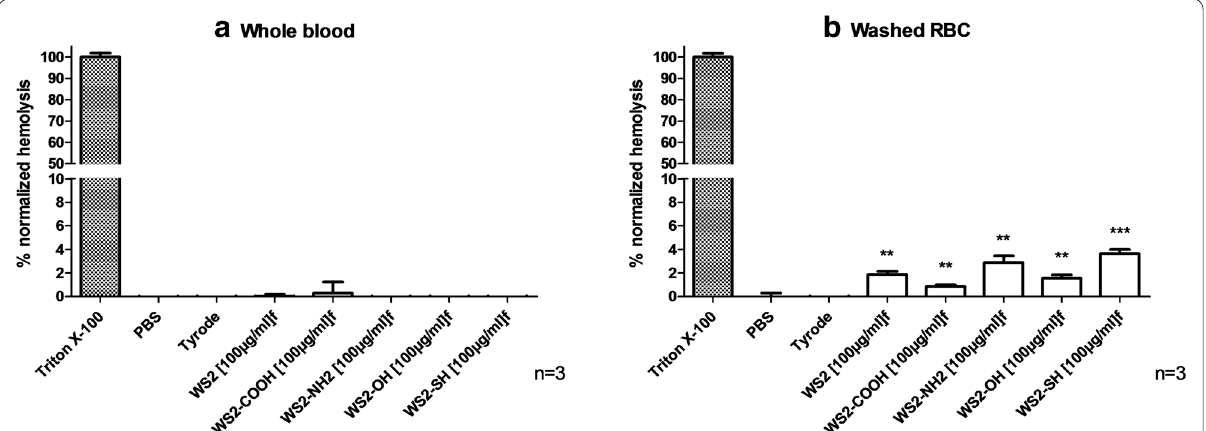
Fig. 2 Impact of INTs‑WS 2 / f ‑INTs‑WS 2 on hemolysis after 1 h at 100 μg/mL. Experiments were performed on a whole blood and b washed RBC. Triton X‑100 1% and Tyrode buffer (v/v) were respectively used as positive and negative controls. Mean (%)